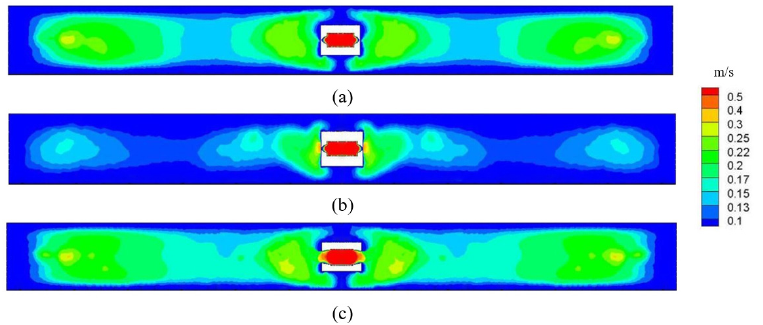
Figure 5. The velocity distribution of free surface with different ( a ) SEN A, ( b ) SEN B and ( c ) SEN C.